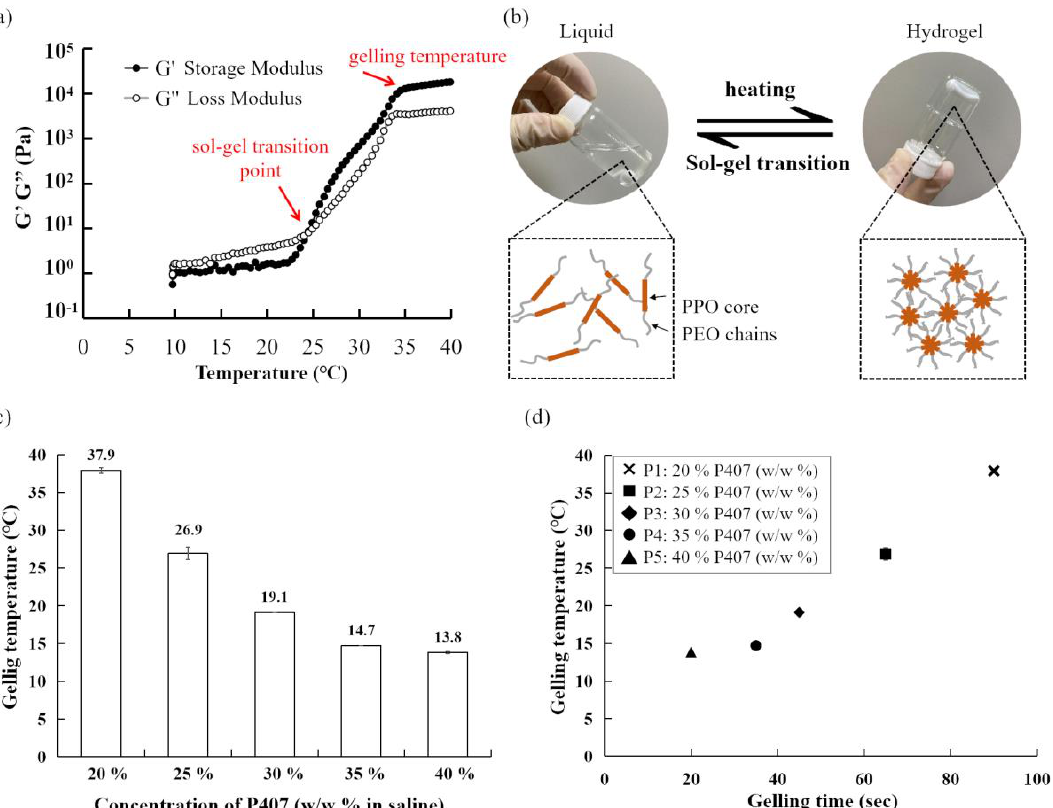
Figure 1. ( a ) Represented graphic for rheological behavior measured by the rheometer. Red arrow: the sol- gel transition temperature where G′ and G″ were equal , and gelling temperature; ( b ) sol-gel transition of P407-based hydrogel; ( c ) average gelling temperature of P407-based hydrogel at different concentrations of P407 (20, 25, 30, 35, 40% w / w of P407 in 10 g saline); ( d ) gelling time of P407-based hydrogel at different concentrations of P407. Table 2. Components in the formulation of P407-based hydrogel blended with different ratios of P188 ( w / w % in 10 g